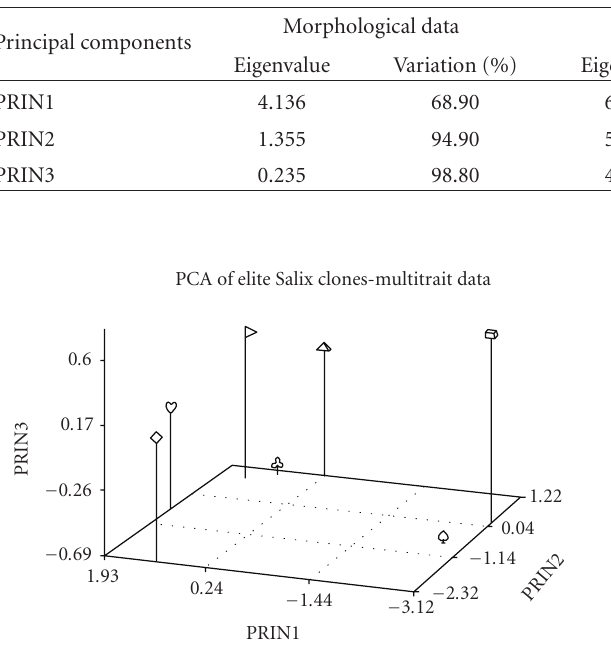
Figure 1: Ordination of Salix clones on three-dimensional prin- cipal space based on the analysis of quantitative characters.